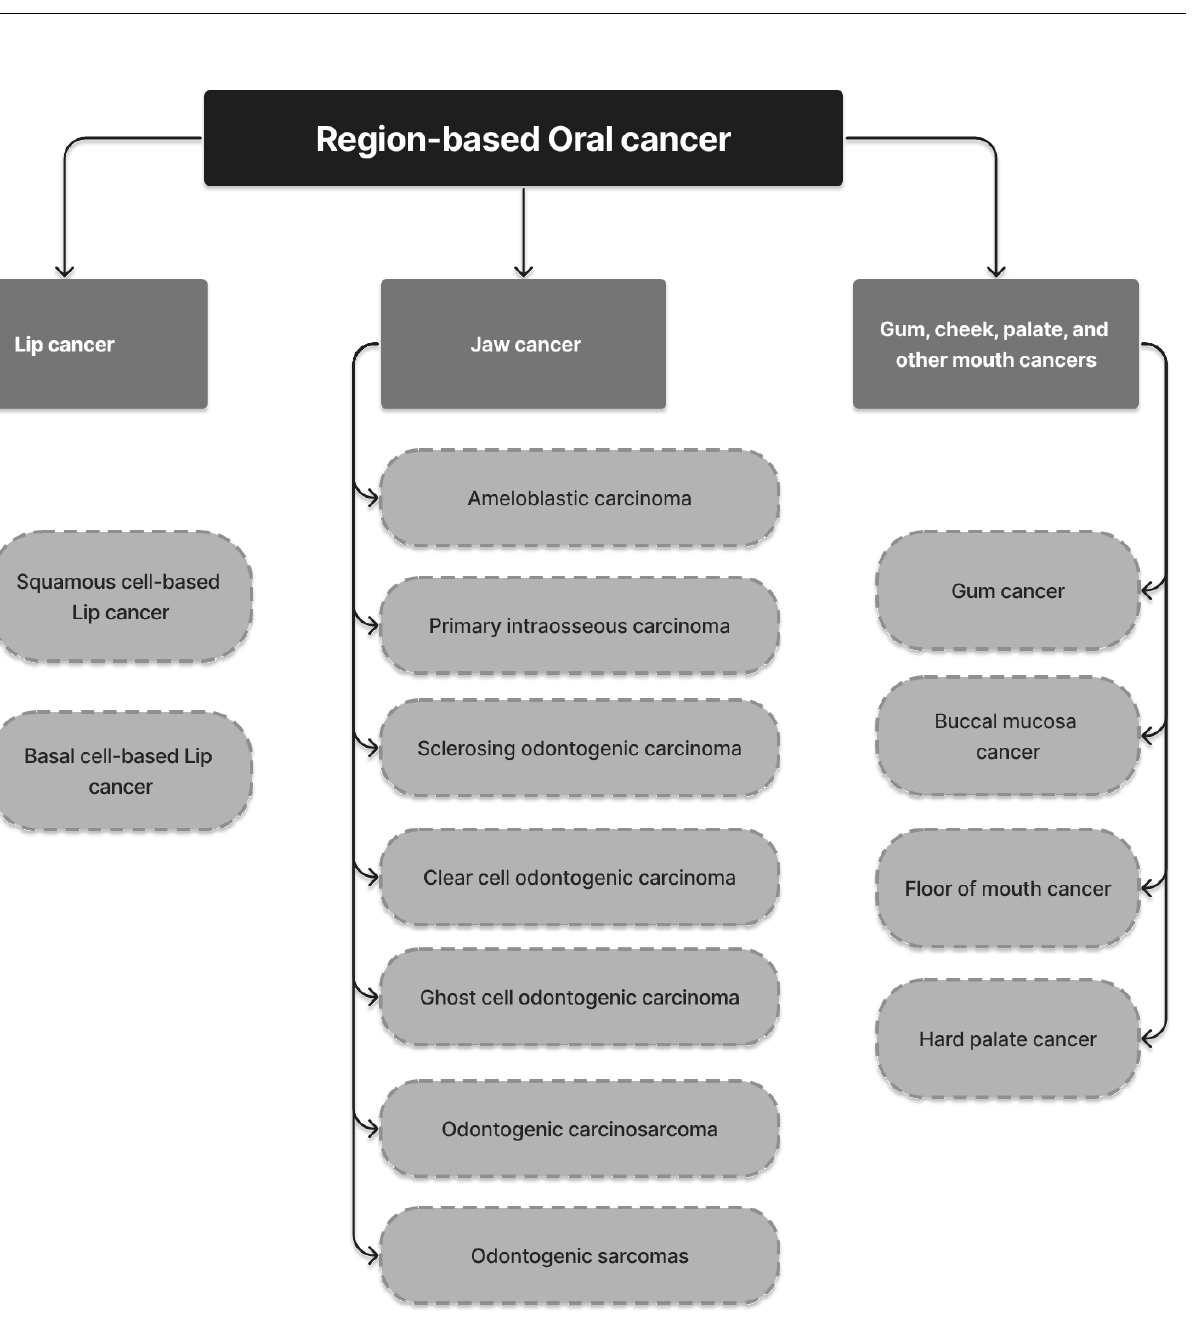
Figure 7. Classification of OC based on the origin location of lesion.